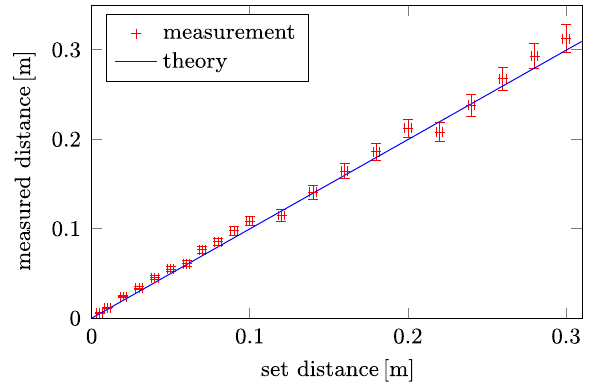
FIG. 11. Distances obtained from data analysis of a full series of OST spectra versus the distance obtained from the mechanical setup. FIG. 12. Drawing of the vertical mounting of the OST. In red